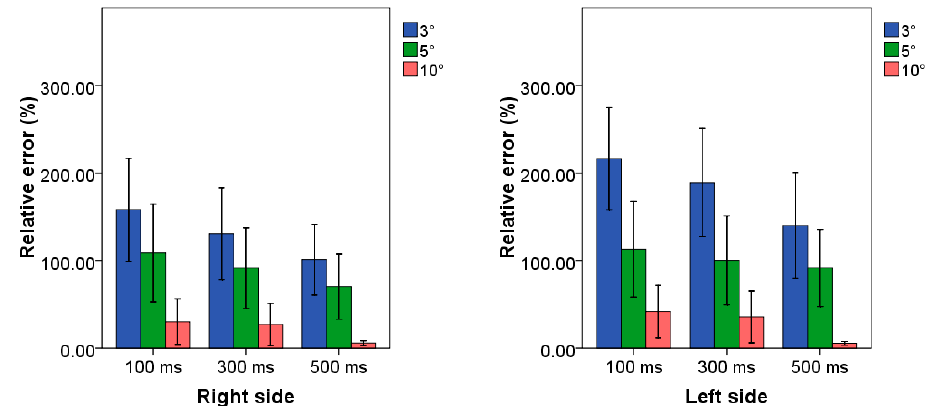
Figure 3. Relative errors related to the case study at low frequency for both side of all combinations of TB procedure. Blue, green and red bars represent the combination in which the threshold amplitude is set to 3 ◦ , 5 ◦ and 10 ◦ , respectively. Clusters on x -axis represent the possible time threshold value. Each bar corresponds to a specific combination among the nine tested algorithms.